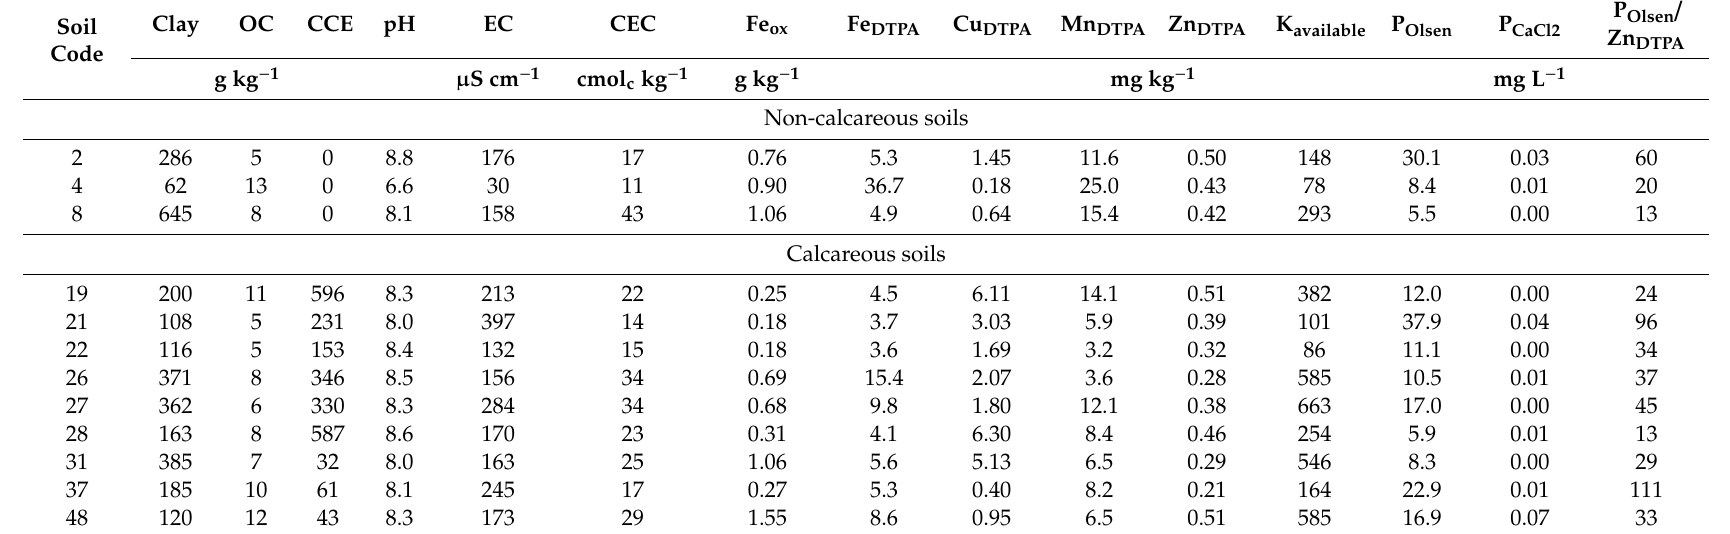
Table 1. Selected properties ‡ of the